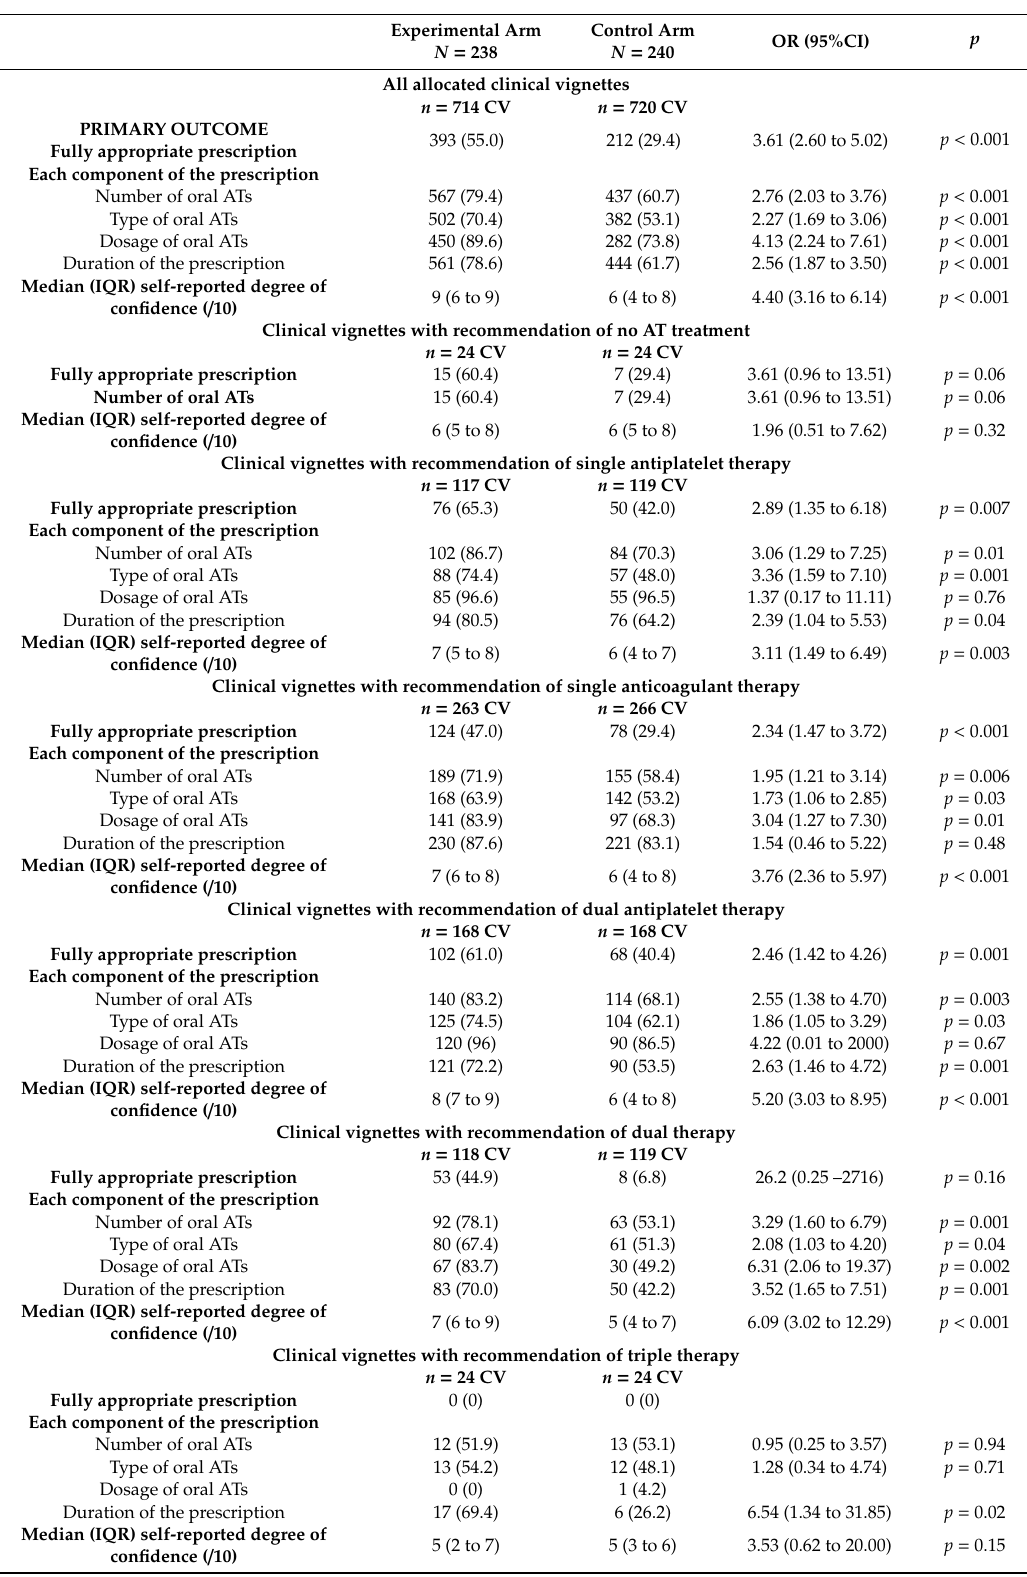
Table 2. Primary and secondary outcomes: compliance with guidelines for oral AT prescriptions by trial arm. Values are numbers (percentages) unless stated